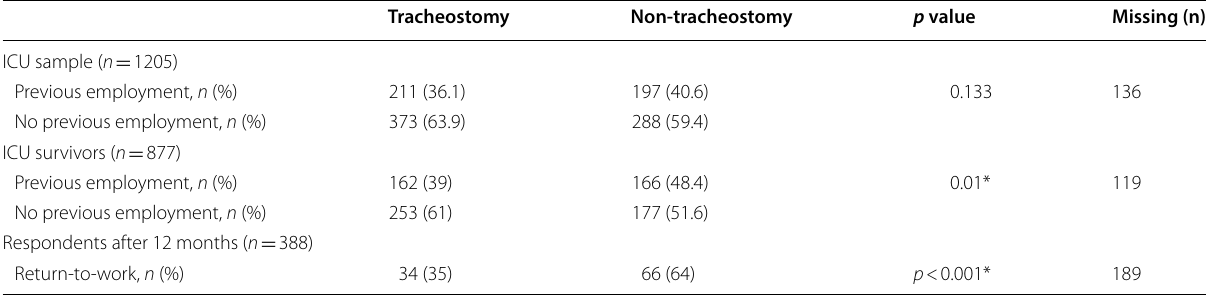
Table 2 Univariate analysis of the employment status of ARDS patients before ICU treatment and return-to-work